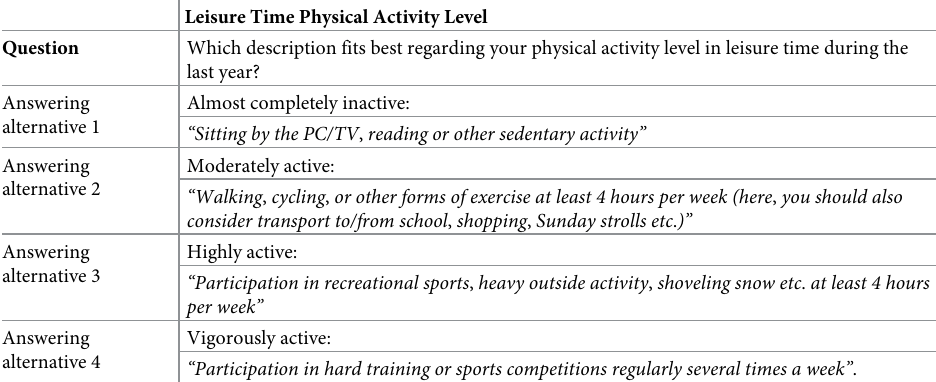
Table 1. Saltin-Grimby Physical Activity Level Scale